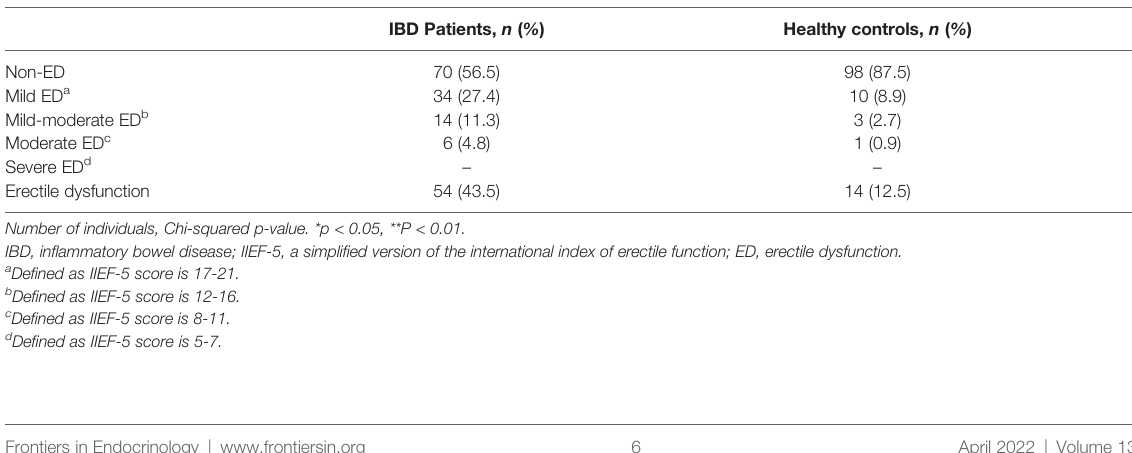
TABLE 5 | Comparison of IBD patients and healthy controls for IIEF-5.